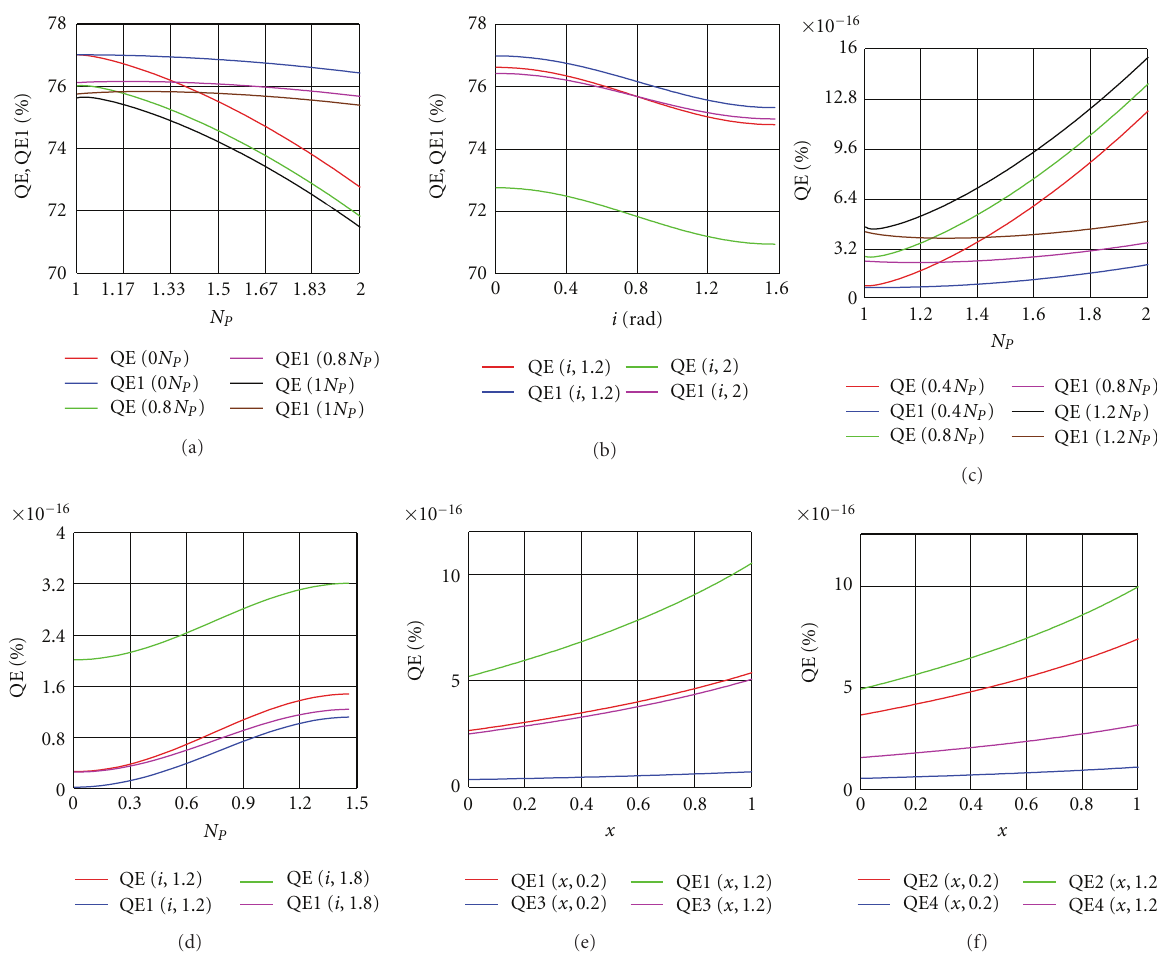
Figure 8: (a) Quantum e ffi ciency of the transitions between resonant levels for GaAs as a function of the prism refraction index. It is considered the following two main cases: (1) prism angle α = π/ 6 and incidence angle: i = 0 rad (red curve), i = 0 . 8rad (green curve), i = 1 rad (black curve). (2) prism angle α = 2 π/ 3 incidence angle i = 0 rad (blue curve), i = 0 . 8rad (violet curve), i = 1rad (brown curve). (b) Quantum e ffi ciency of the transitions between resonant levels for GaAs as a function of the incidence angle for the ray falling on the prism. (c) Quantum e ffi ciency of the transitions between confinement levels for Al x Ga 1 − x As as a function of the prism refraction index. (d) Quantum e ffi ciency of the transitions between confinement levels for AlGaAs as a function of the incidence angle of the ray falling on the prism. (e) Quantum e ffi ciency of the transitions between confinement levels for Al x Ga 1 − x As as a function of the aluminium quantity; prism refraction index is N p = 1 . 5. (f) Quantum e ffi ciency of the transitions between confinement levels for Al x Ga 1 − x As as a function of the aluminium quantity; prism refraction index is N p =